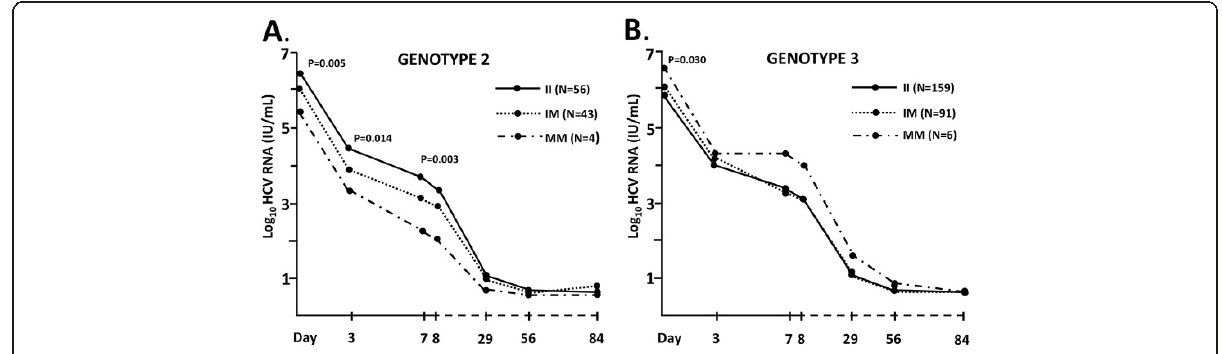
Figure 2 HCV viral load according to the PNPLA3 I148M genotype in HCV genotype 2 (A) and genotype 3 (B) infected patients from start of treatment (day 0) through treatment week 12 (day 84). Viral load is expressed as mean log 10 value at each time point. P values were calculated for the difference in viral load across PNPLA3 I148M genotypes at each time point using linear